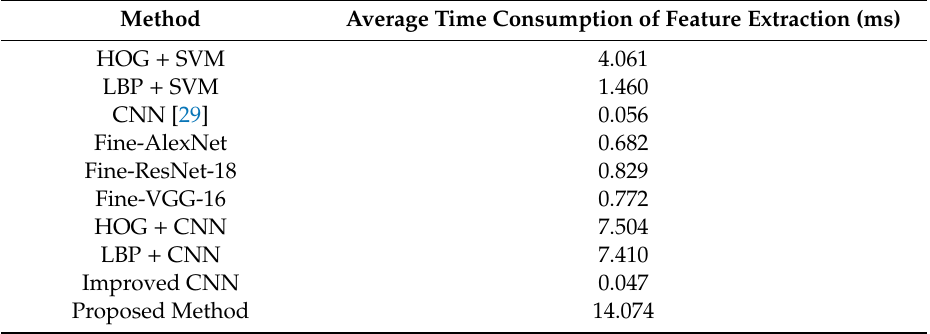
Table 13. The average time consumption of feature extraction per image for the self-built dataset.